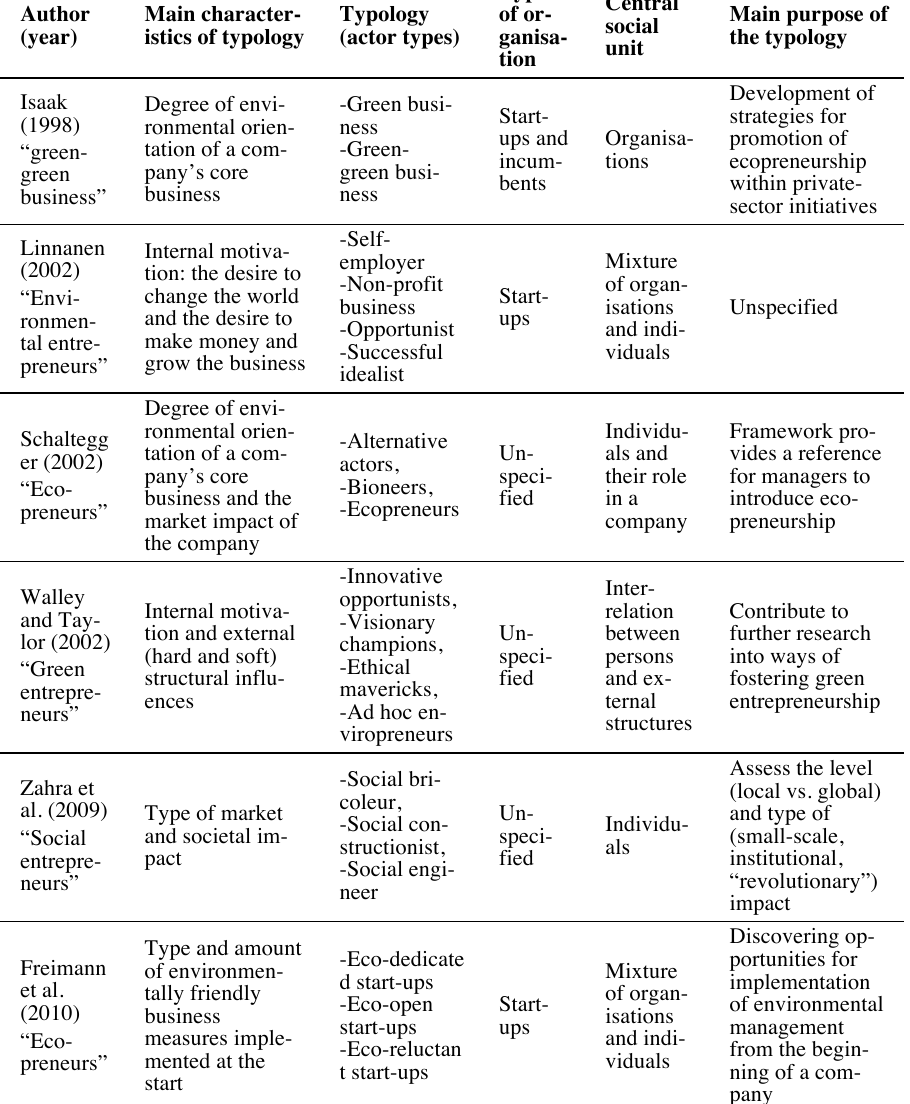
Table 1. Characteristics of typologies in sustainable entrepreneurship